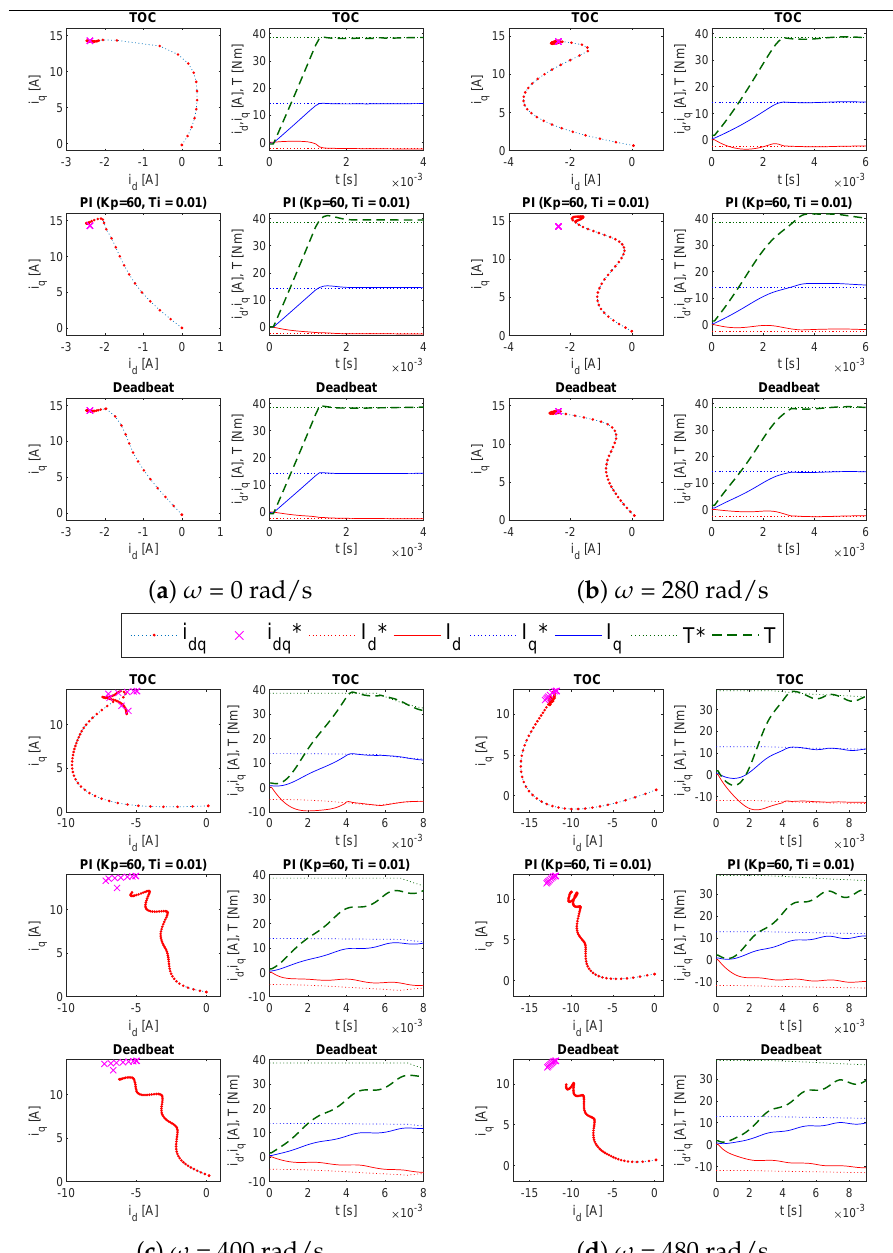
Figure 8. Details of torque and current trajectories at selected moments—( a – d )—of the experimental testing profile. For each transient, we plot the resulting trajectories for TOC controller ( top row), PI controller ( middle row), and deadbeat controller ( bottom row). Trajectories of the currents in the d - q coordinates are displayed in the left subfigures with the requested current values denoted by crosses. Trajectories in the time domain are displayed in the right subfigures. The requested values of the torque and current are marked by dashed